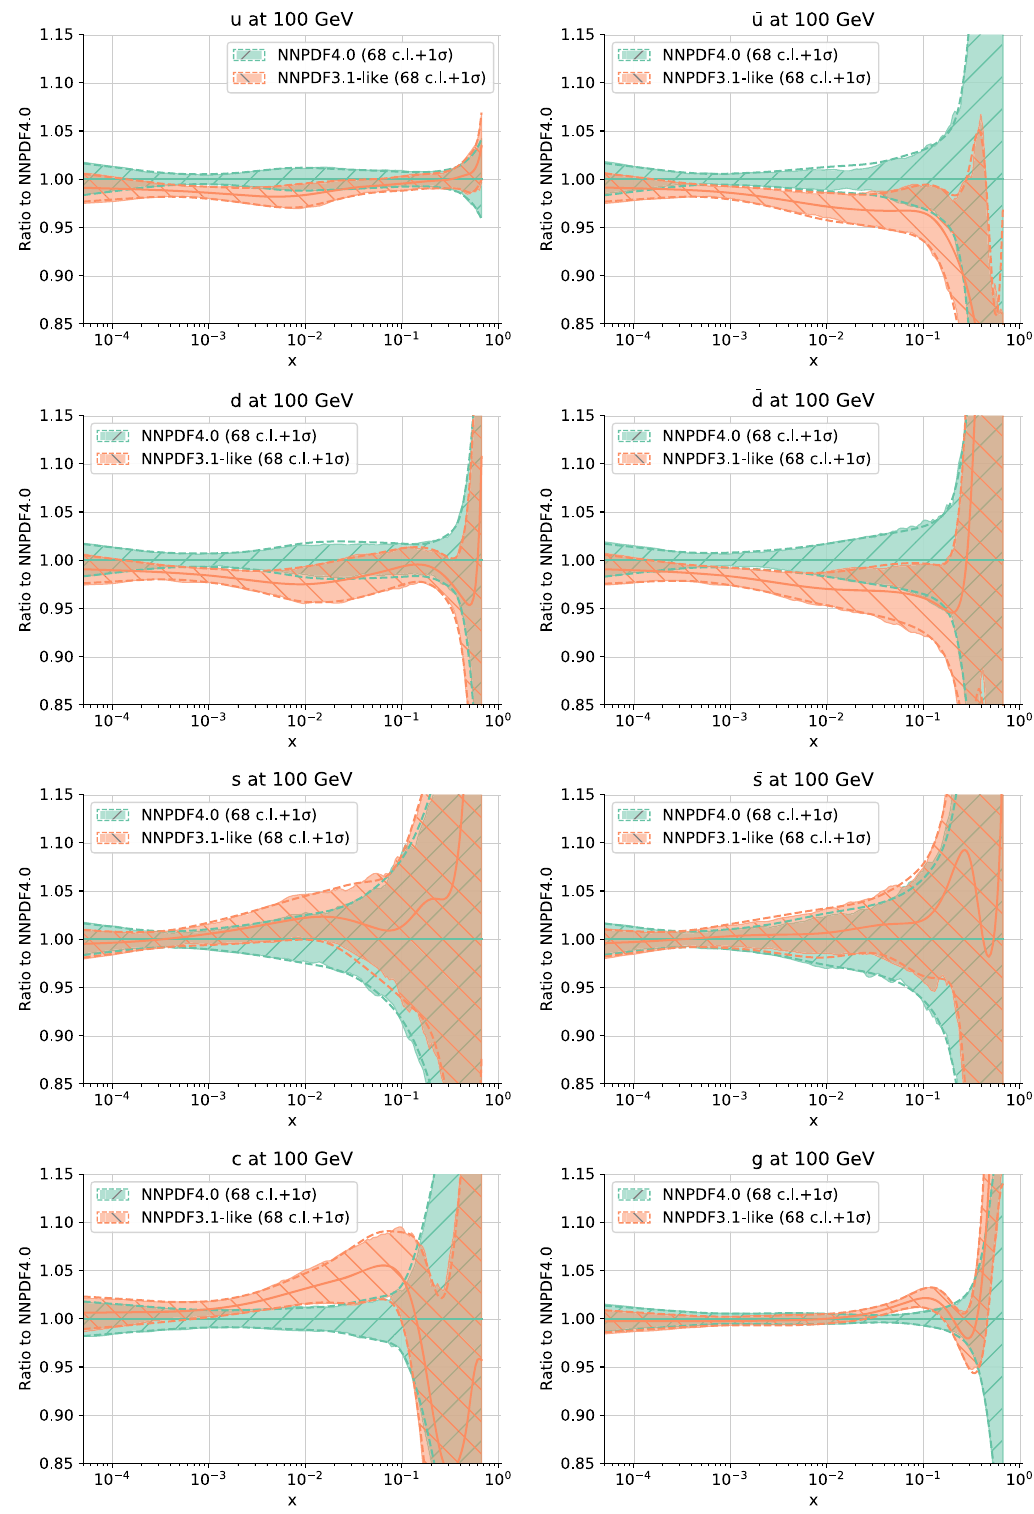
Fig. 33 SameasFig.31nowcomparingtotheNNPDF4.0baselineaPDFsetbasedonthesameNNPDF4.0methodologybutontheNNPDF3.1-like dataset defined in Sect.